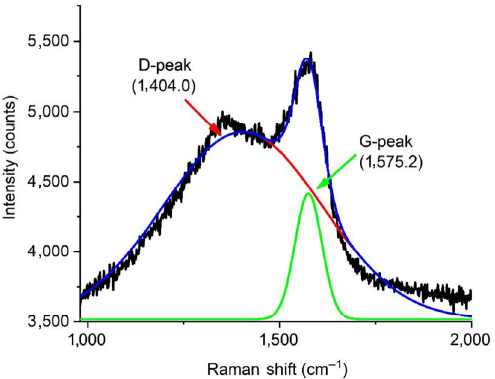
Fig. 11 Raman spectrum of the worn surface at the stem trunnion.